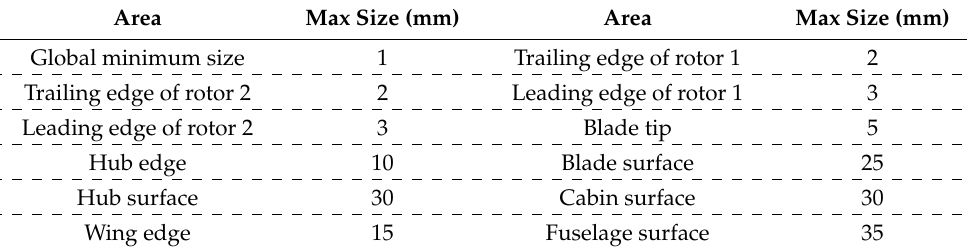
Table 1. The size distribution of the surface grid of each part of the